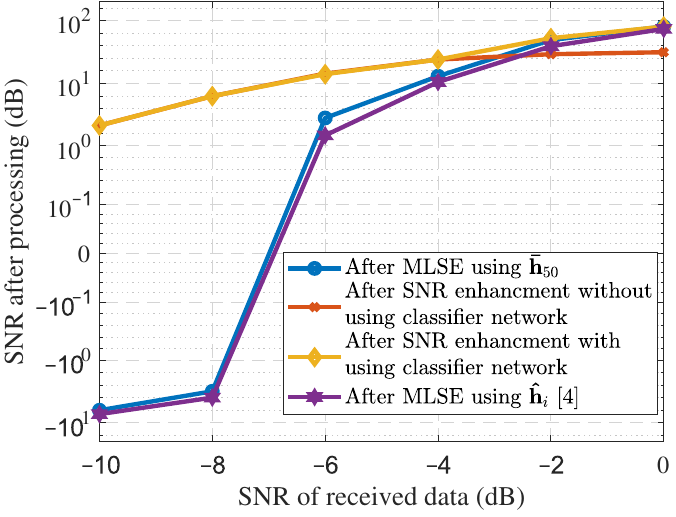
Figure 5. MSE comparison of SSS method and modified updated estimation at SNR = − 5 dB.